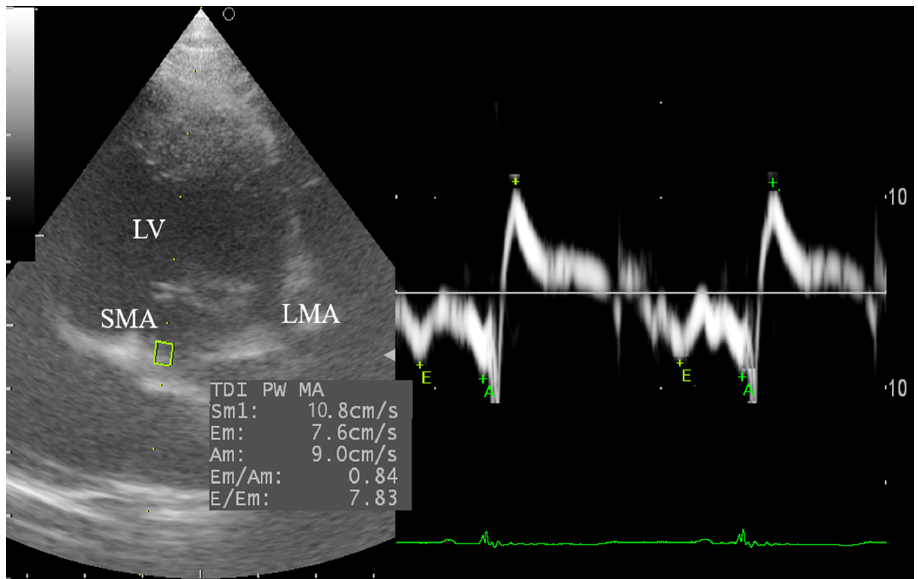
Figure 5. Tissue Doppler imaging (TDI) of male goat’s heart obtained from the left apical 4-chamber view at the septal and lateral mitral annulus (SMA, LMA). The sample volume was adjusted at 3.5 mm. The spectral velocity is expressed as systolic velocity (+, Sm) and two diastolic waves (E, Em; A, Am) which respectively evaluate the early and late diastolic mitral annular velocities.